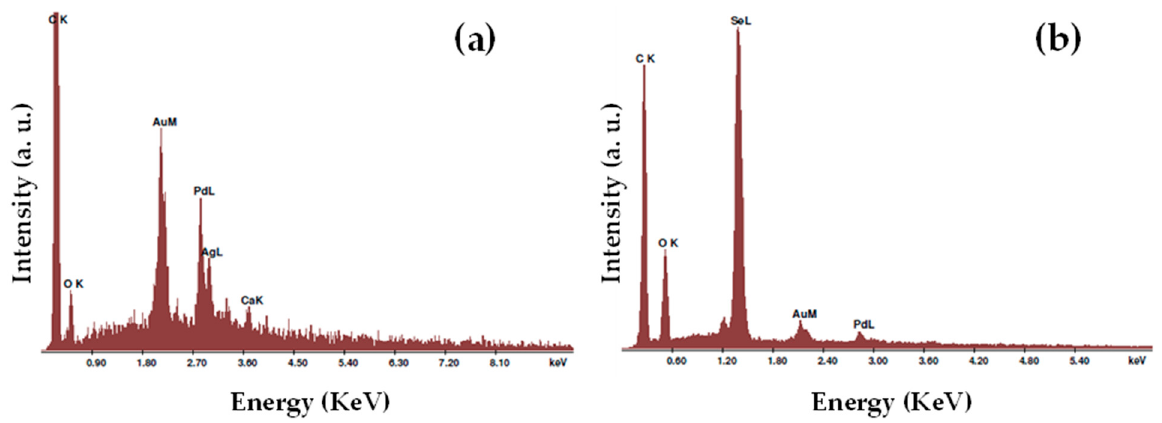
Figure 2. EDX spectra of PSNC1 ( a ) and PSNC4 ( b ) nanocomposites.